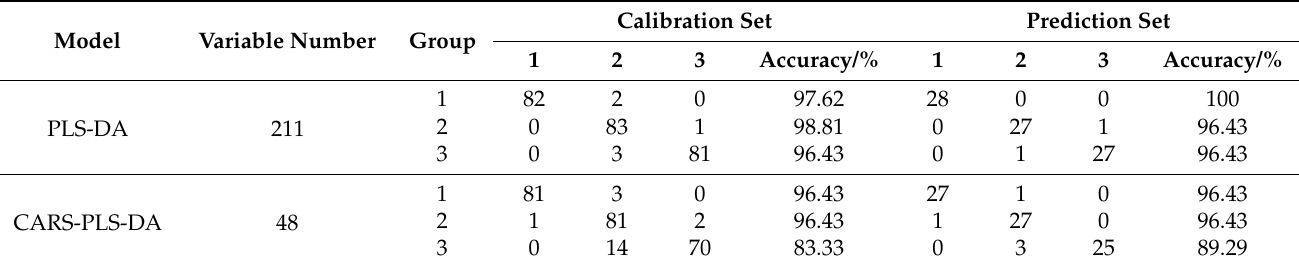
Table 1. Classification results based on partial least square- discrimination analysis (PLS-DA) and competitive adaptive reweighted sampling-PLS-DA (CARS-PLS-DA) models.